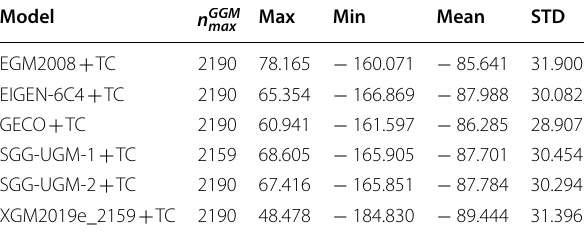
Table 4 The statistics of the differences between the gravity anomaly derived from gravity field models and the measured data after terrain correction in plateau area (unit: mGal) Model